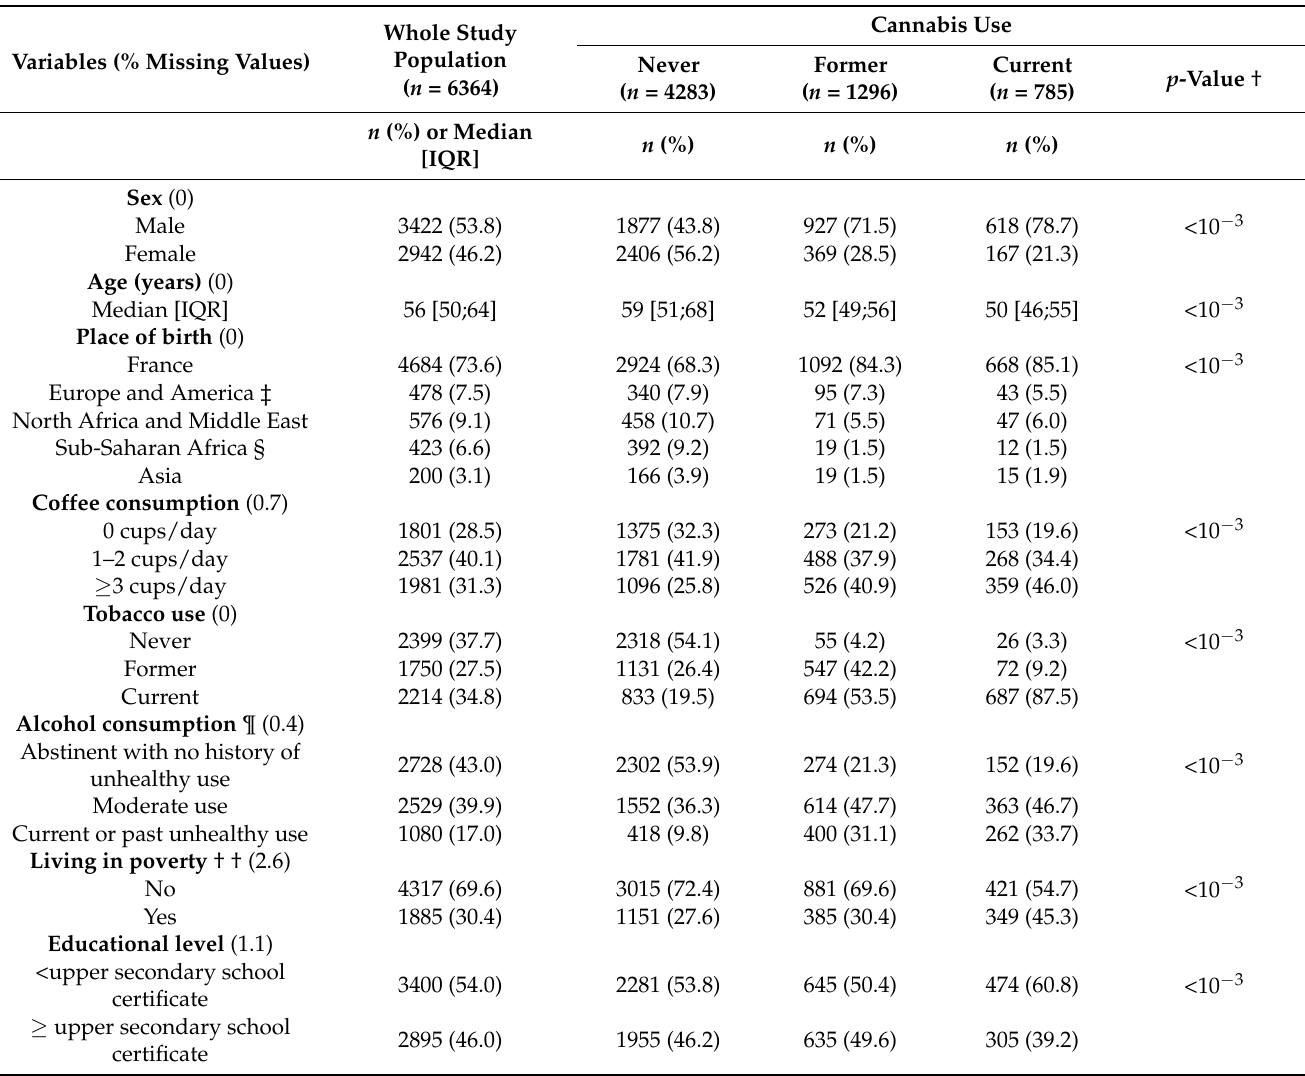
Figure 1. Flow chart of the study population (ANRS CO22 Hepather cohort). Table 1. Study population characteristics, according to cannabis use (ANRS CO22 Hepather cohort, n = 6364 patients with chronic HCV